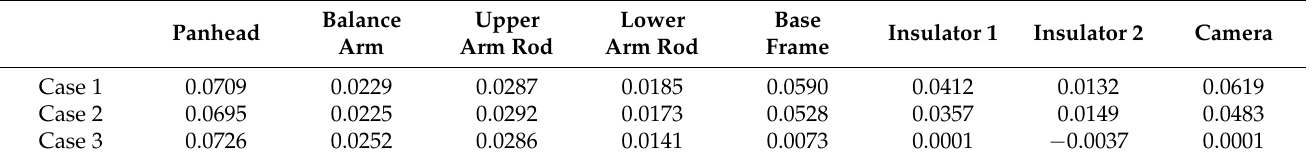
Table 5. Computed drag coefficients of each pantograph part.